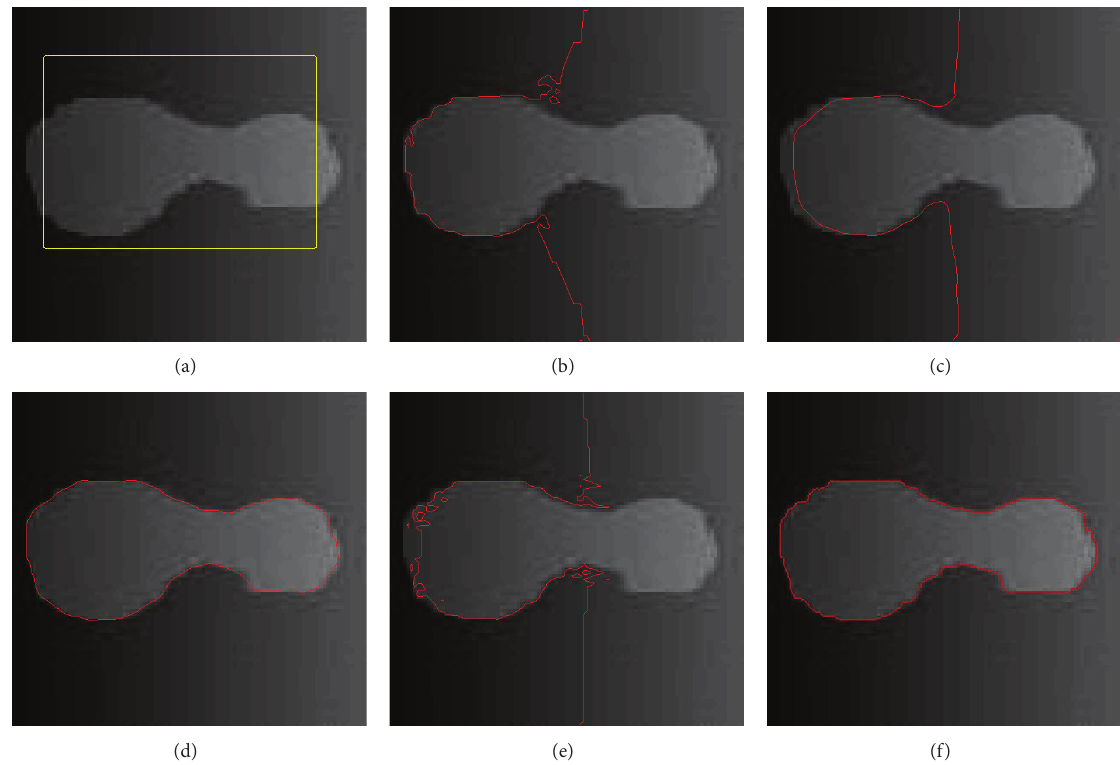
Figure 11: Segmentation results on the synthetic image: (a) the initial contour, (b) CV result, (c) GACV result, (d) DRLSE result, (e) FAC result, and (f) LFAC